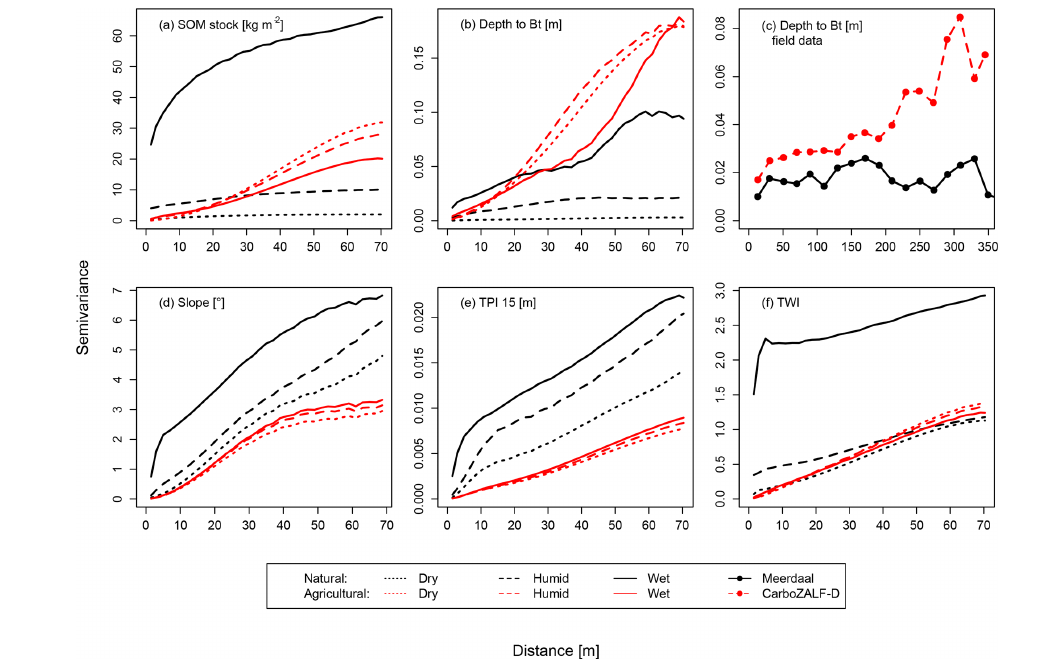
Figure 6. Experimental semivariograms of the model results showing semivariance for different soil (a, b) and terrain properties (d–f) with different precipitation scenarios (line types) at the end of the natural (black) and agricultural (red) phases. For comparison, panel (c) shows experimental semivariograms of depth to Bt from a natural area (Meerdaal forest, P = 800mm, Vanwalleghem et al., 2010) and an agri- cultural area (CarboZALF-D, P = 500mm, Van der Meij et al., 2017). Note that these field data are presented with different axes. The experimental semivariograms are displayed with lines rather than points for easier visual comparison. Table 2. Model and field organic carbon stocks (kgm − 2 ) for different depth ranges, averaged over the catchment (average ± standard deviation). The model results were converted from SOM to SOC by multiplying the SOM stocks by 0.58 (Wolff,